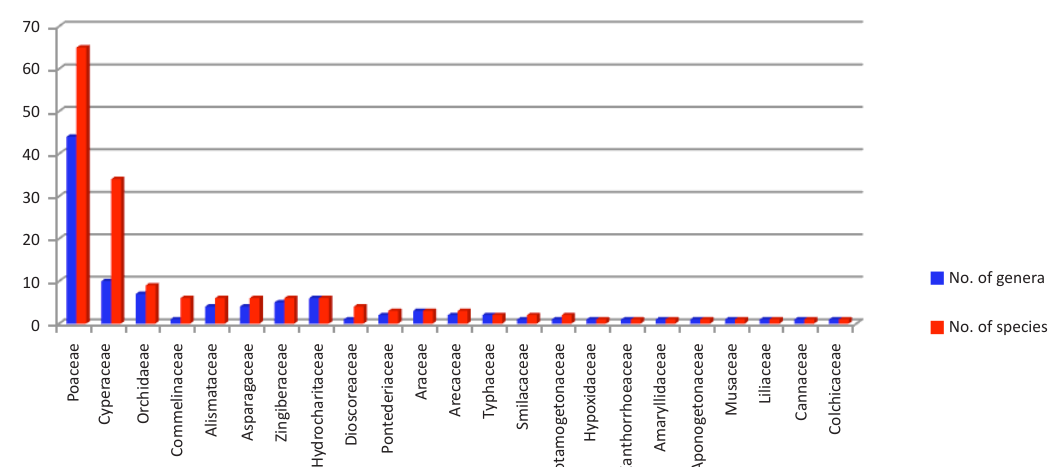
Figure 5. Largest families in